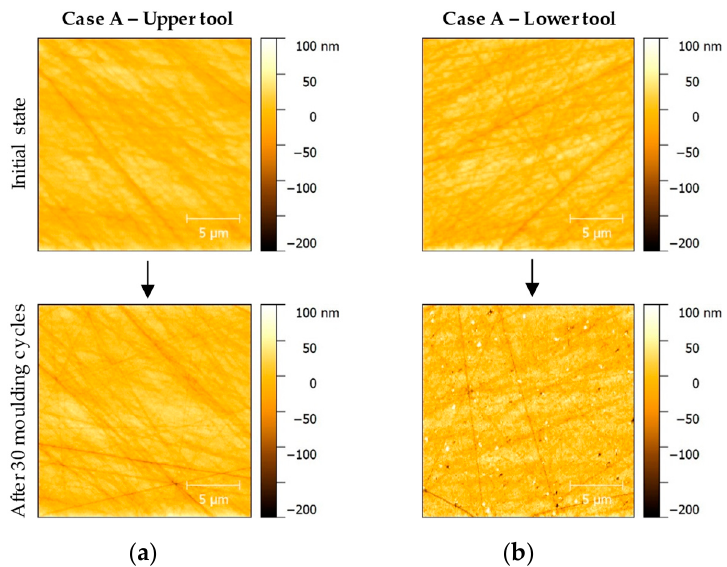
Figure 15. AFM inspection of moulding samples in initial state and after 30 moulding cycles: ( a ) Case A—Upper tool; ( b ) Case A—Lower tool.